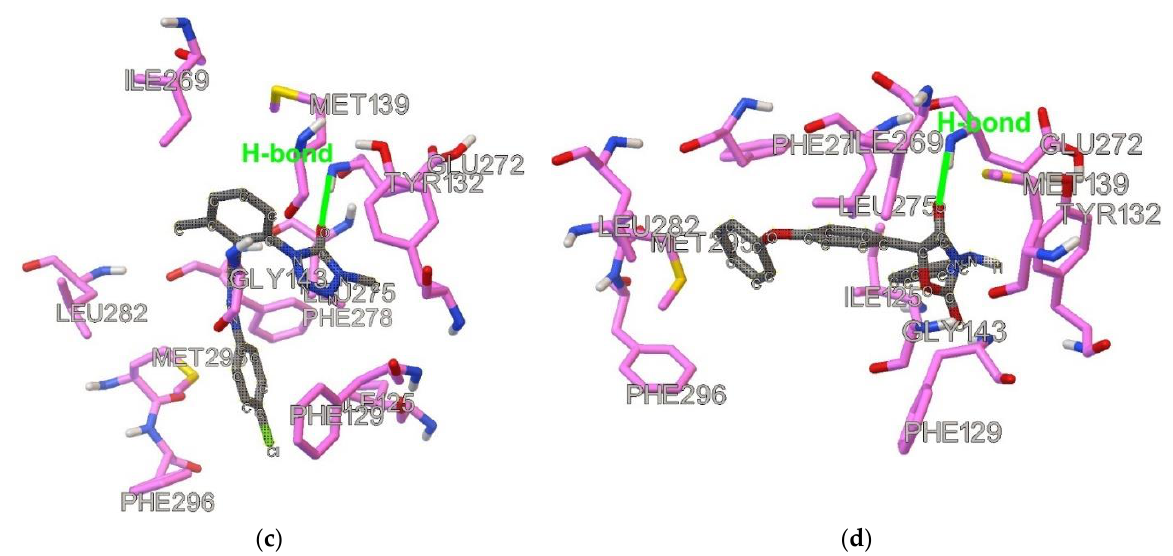
Figure 2. Docked and optimized conformation for the following QoI-s: ( a ) Pyribencarb, ( b ) pyraclostrobin, ( c ) metyltetraprole, ( d ) famoxadone. Ligand is shown with gray carbon atoms.